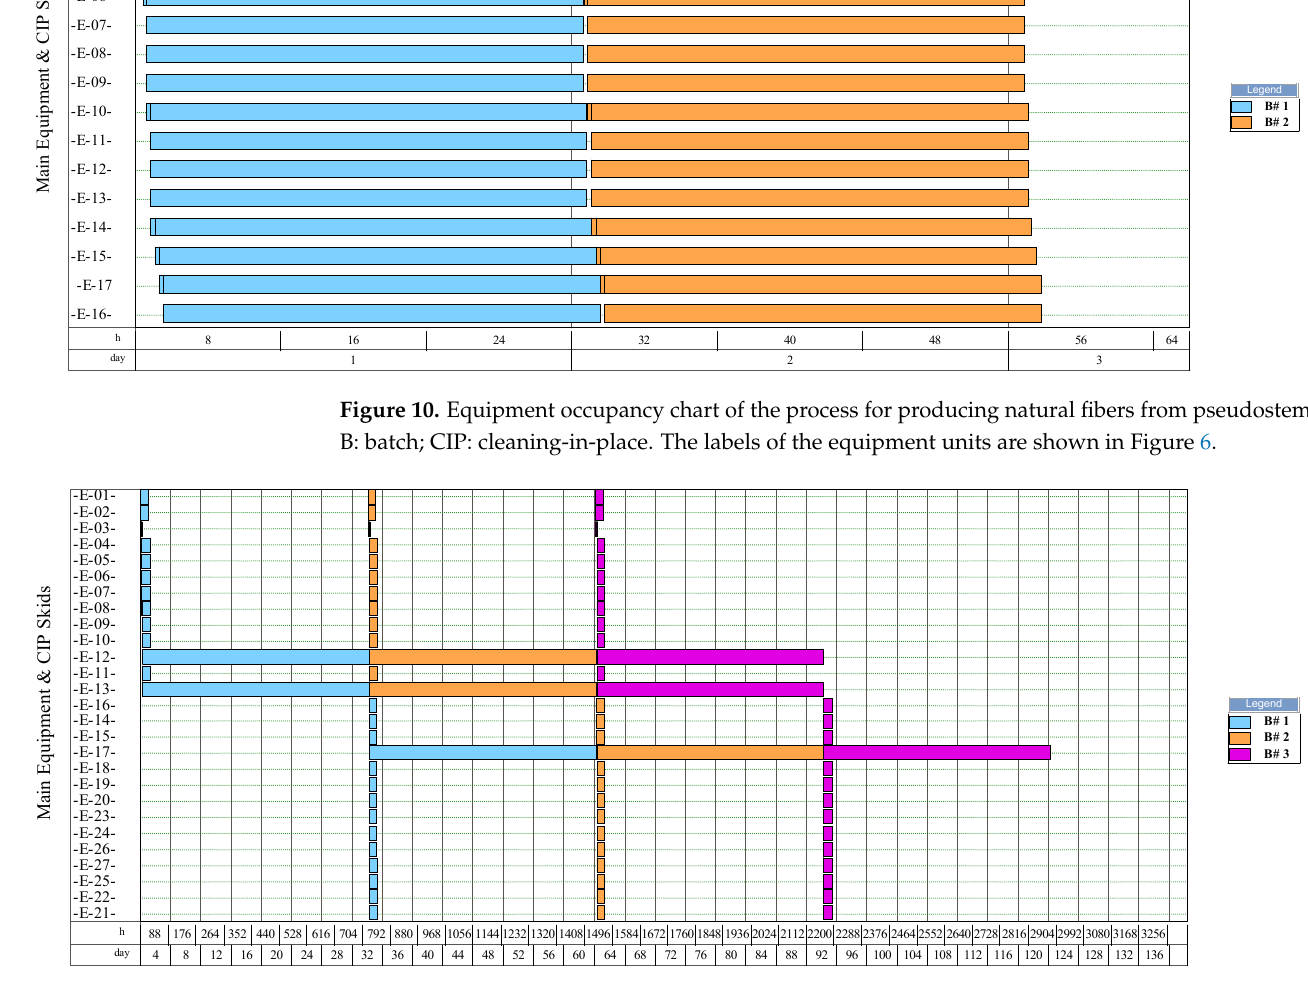
Figure 11. Equipment occupancy chart of the process for producing biomethane from pseudostems. B: batch; CIP: cleaning-in-place. The labels of the equipment units are shown in Figure 7.